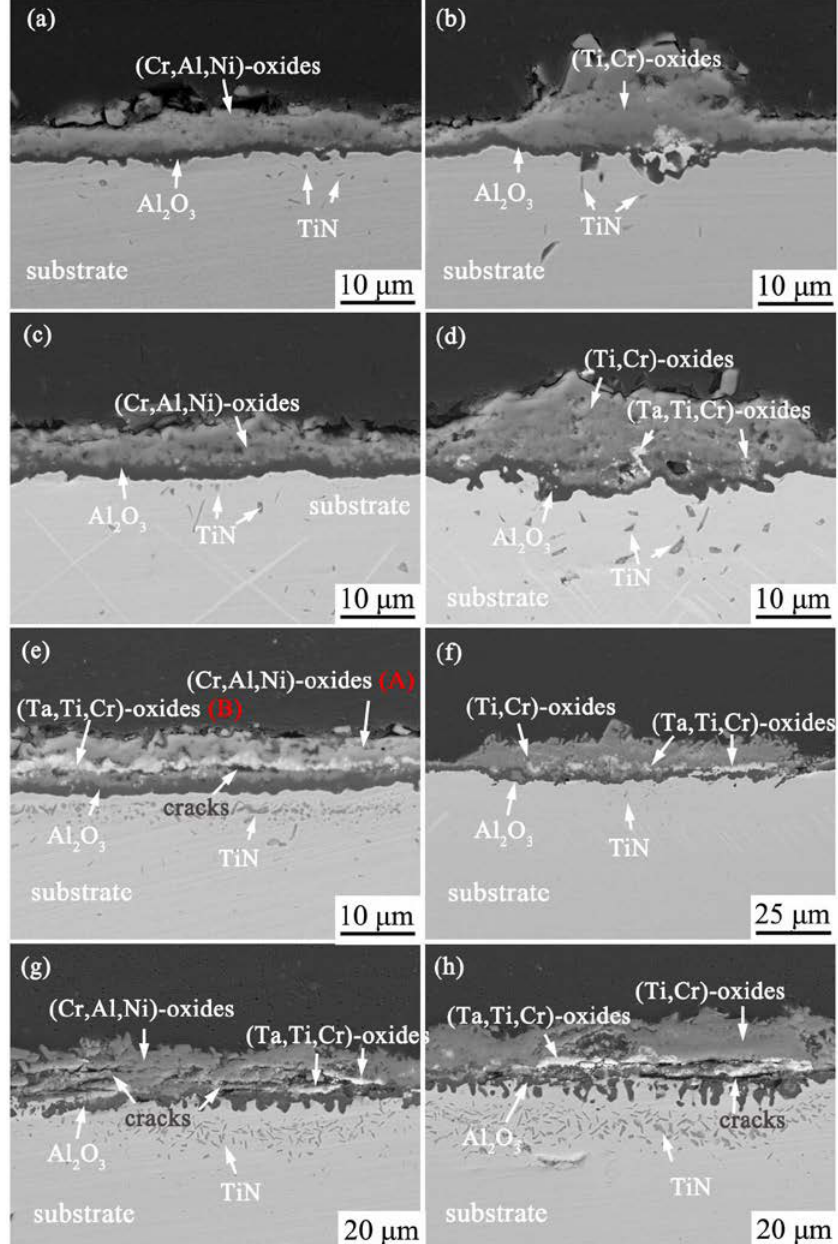
Figure 11. Cross-section morphologies of the oxide scales formed on the E7, E71, E73 and E75 alloys after oxidation at 1000 ◦ C for 500 h. ( a , c , e , g ): Flat surface regions on the E7, E71, E73 and E75 alloys at 500 h, respectively. ( b , d , f , h ): Oxides clusters on the E7, E71, E73 and E75 alloys at 500 h, respectively. “A” and ”B” represent the products at which it is labeled. The products information corresponding to “A” and “B” is listed in Table